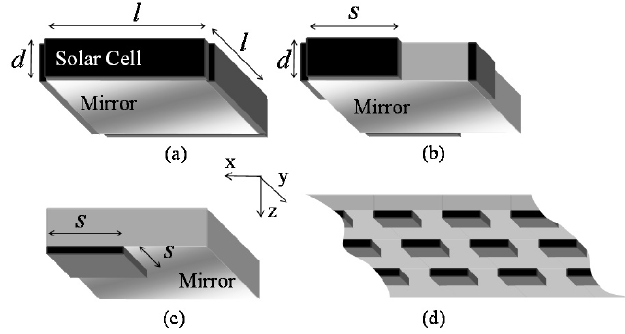
Fig. 1. Sketch of the fluorescent collector geometries compared in the present paper (seen from the bottom). (a) Classical de- sign with the solar cells mounted at each side of the collector with length l and thickness d . (b) Modified classical system where only a fraction of the respective collector sides is cov- ered with a solar cell area A cell = ds . (c) Collector with solar cells with an area A cell = s 2 mounted at the bottom. In all cases the (remaining) back side is covered with a mirror. (d) Systems (b) and (c) are assumed to be periodic in space. Ex- emplary, a detail of the bottom-mounted system is shown.